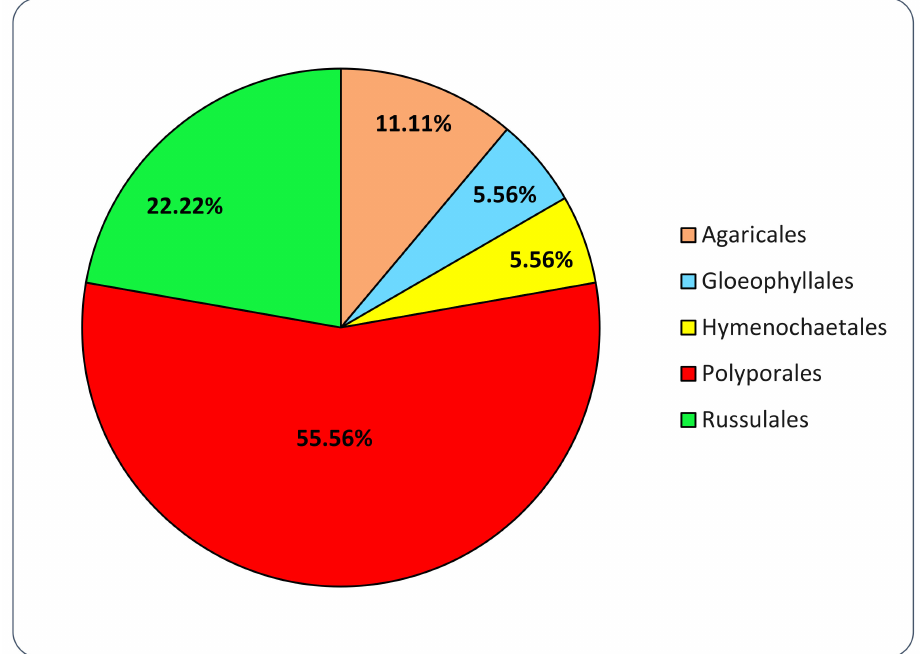
Figure 5. Orders represented in the set of isolated strains included in this